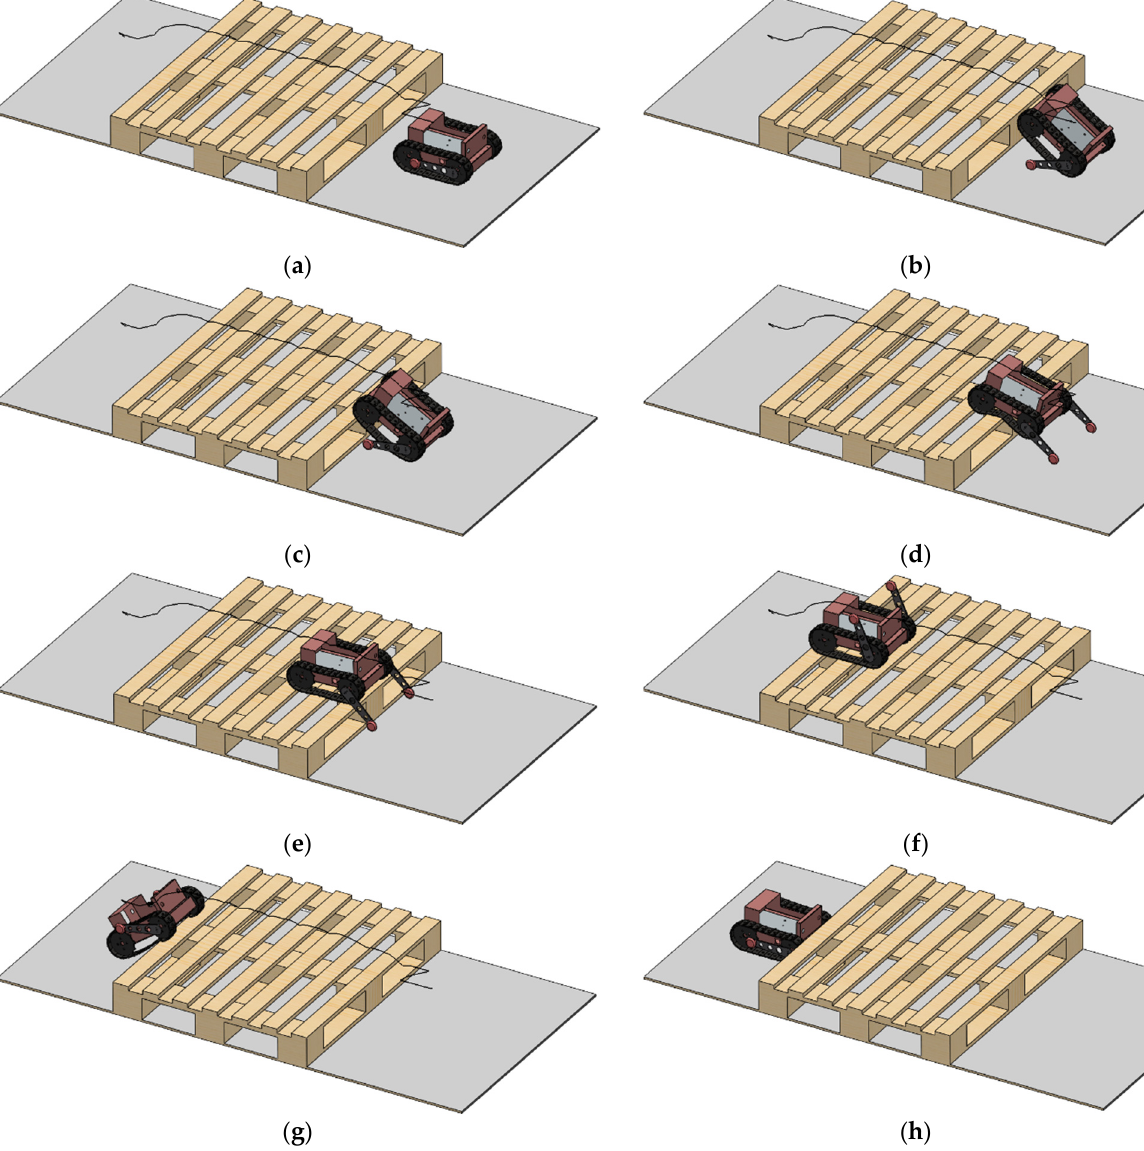
Figure 6. Dynamic simulation snapshots of the robot overpassing the pallet design in Figure 5: ( a ) approach; ( b ) legs rotate cw; ( c ) robot moves forward; ( d ) legs rotate ccw; ( e ) robot advances; ( f ) robot negotiates with the five slopes; ( g ) robot moves forward and descends; h) robot descends completely.